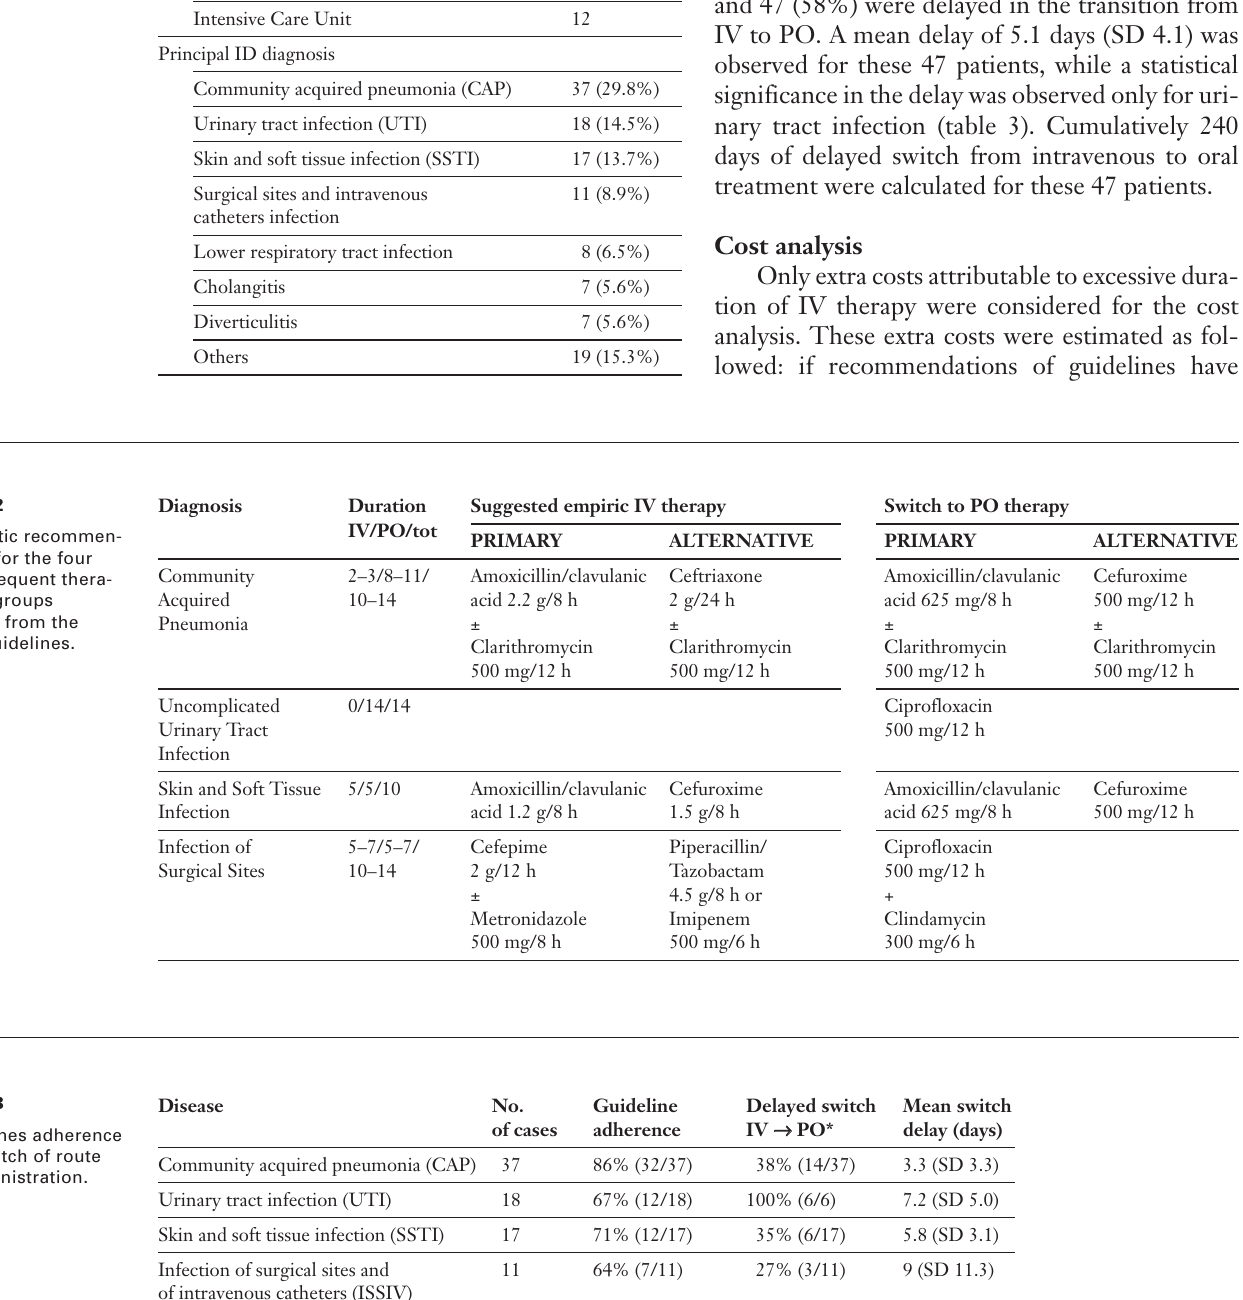
Baseline character- istics and principal diagnosis of 129 patients included in the study.